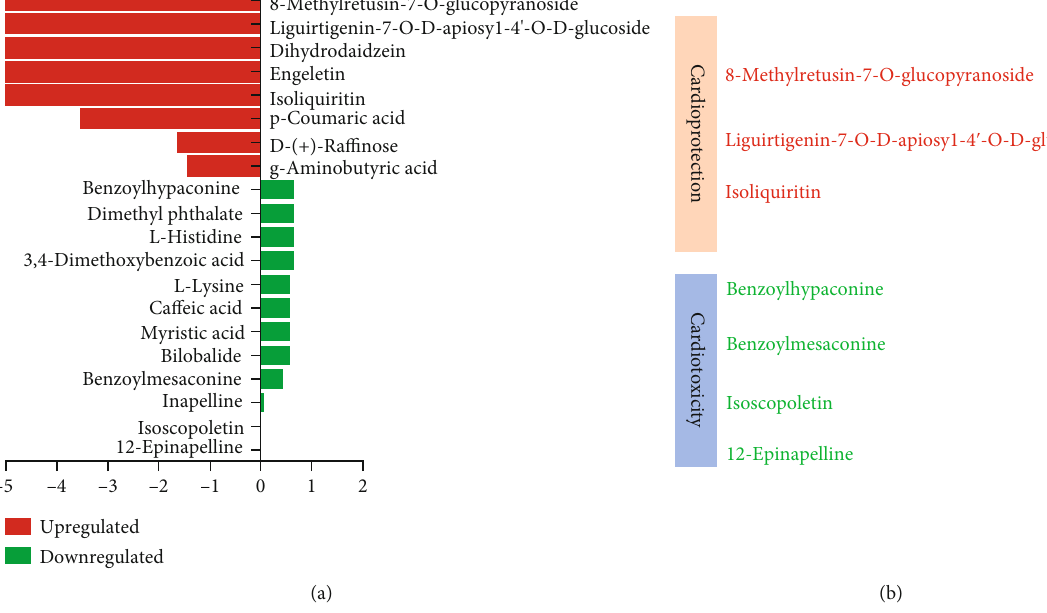
Figure 9: Component comparison of crude Fuzi (CFZ) and CFZ combined with Glycyrrhiza (CFZ+GC) related to function. (a) Signi fi cantly changed composition in CFZ+GC water extract compared with CFZ water extract. (b) E ff ects of changed ingredients on the